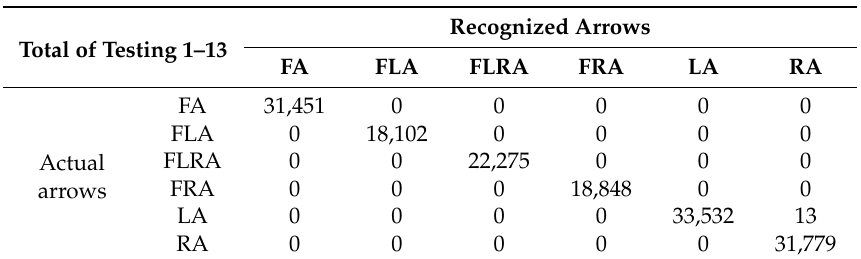
Table 7. The summated confusion matrix by revised CNN.